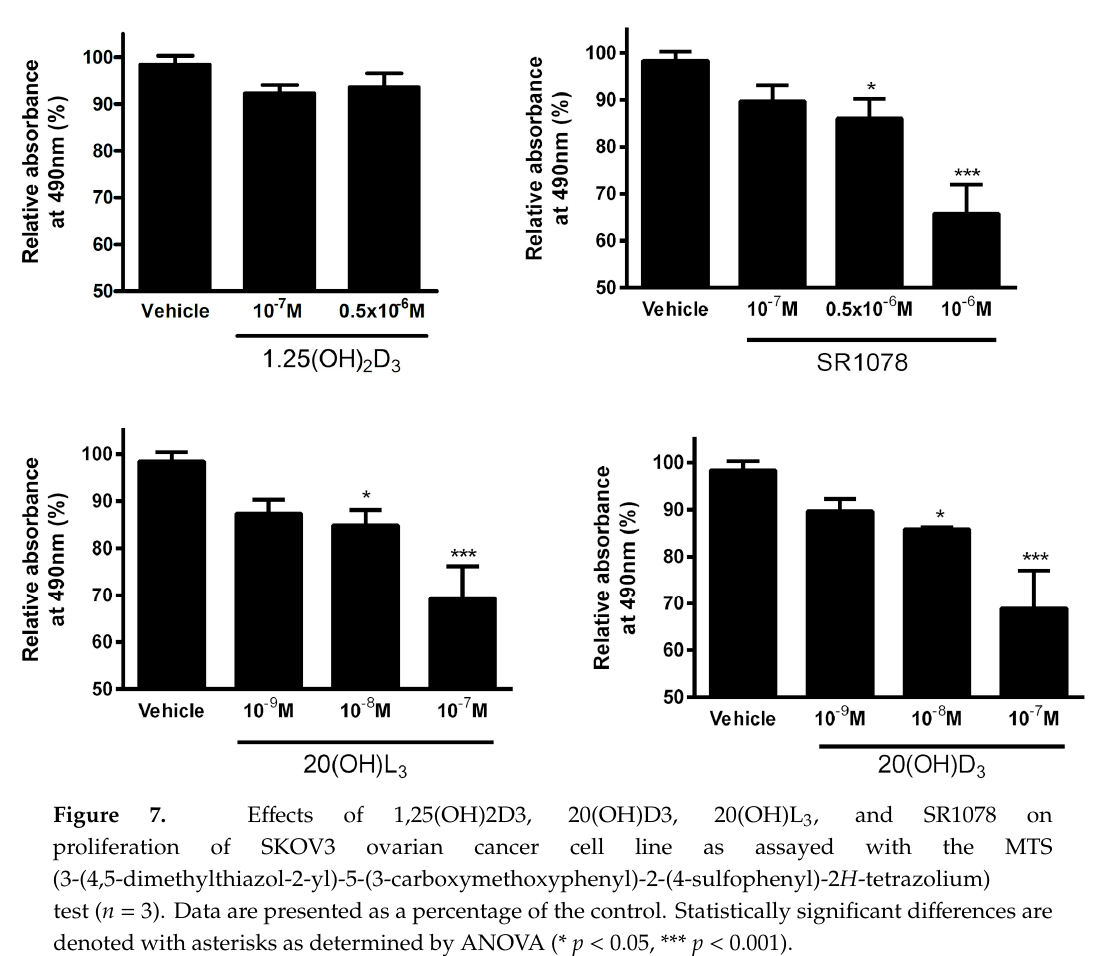
Figure 7. Effects of 1,25(OH)2D3, 20(OH)D3, 20(OH)L 3 , and SR1078 on proliferation of SKOV3 ovarian cancer cell line as assayed with the MTS (3-(4,5-dimethylthiazol-2-yl)-5-(3-carboxymethoxyphenyl)-2-(4-sulfophenyl)-2 H -tetrazolium) test ( n = 3). Data are presented as a percentage of the control. Statistically significant differences are denoted with asterisks as determined by ANOVA (* p < 0.05, *** p < 0.001). In OVCAR-3 cells 1,25(OH) 2 D 3 , 20(OH)L 3 , and SR1078 inhibited cell proliferation in a